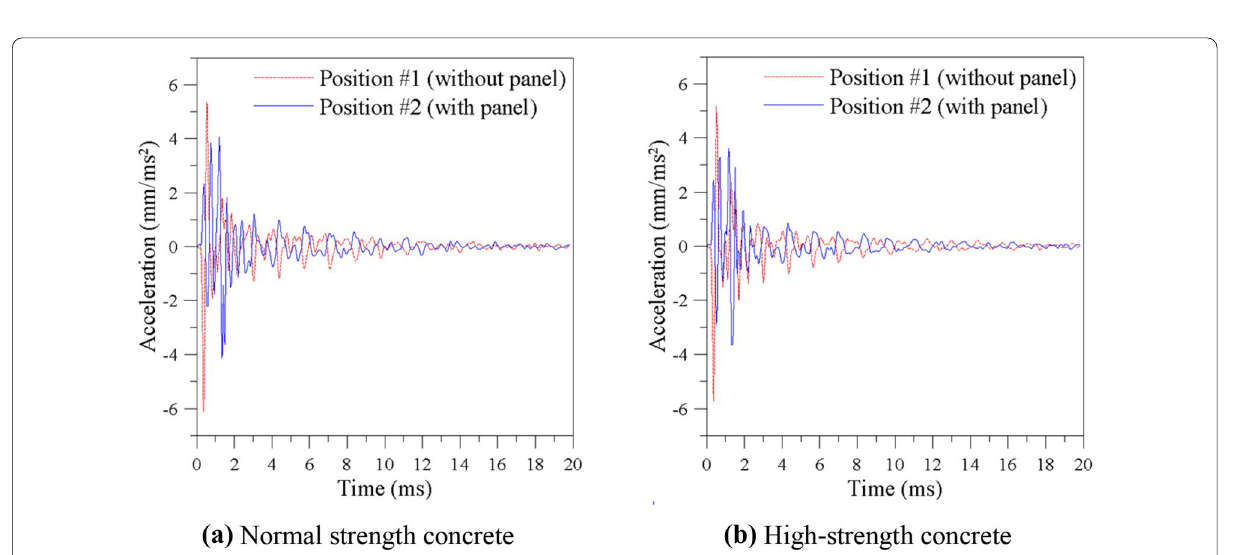
Fig. 9 Acceleration measured at outside wall in preliminary numerical simulation.